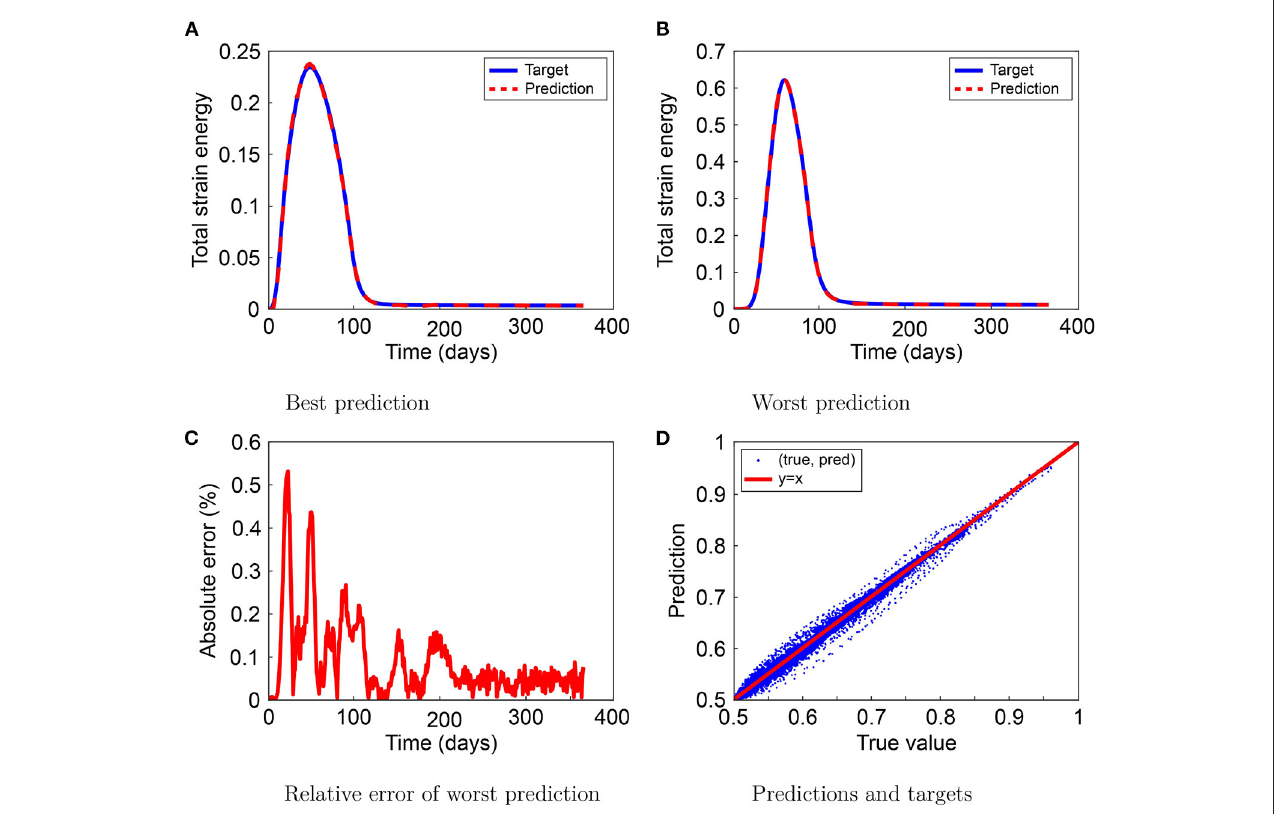
FIGURE3 Results for the total strain energy (TSE) prediction by the neural network. The figure shows the best (A) and worst (B) predictions, the worst prediction relative error (C) , and the prediction-target relation (D) .